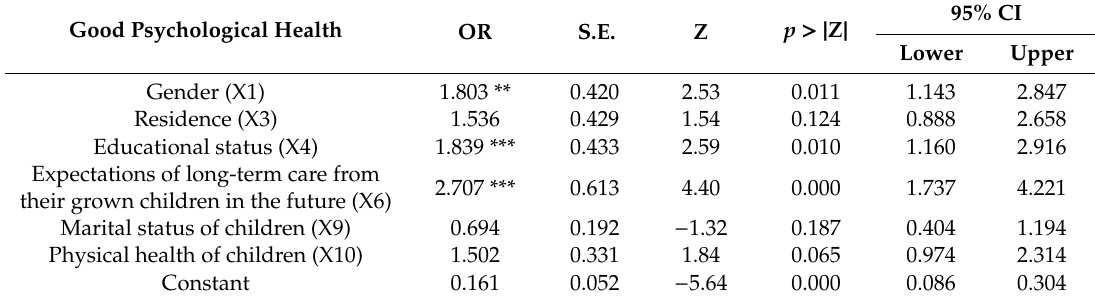
Table A4. Logistic regression results in the sixth step (full details).